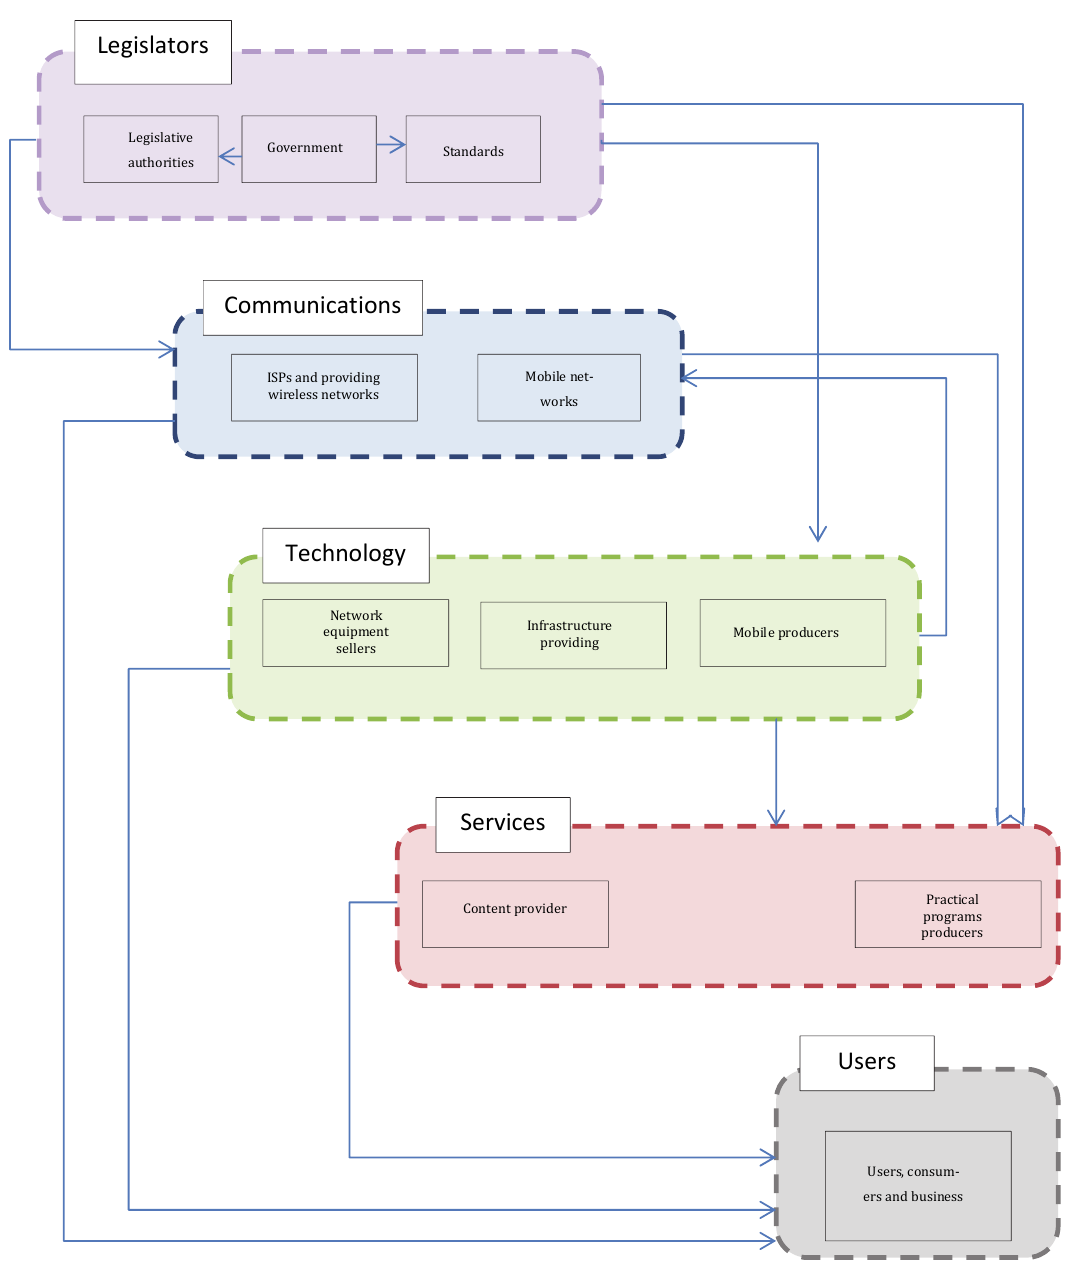
Fig.1. A conceptual model for investigating value chain of mobile services in Iran’s capital